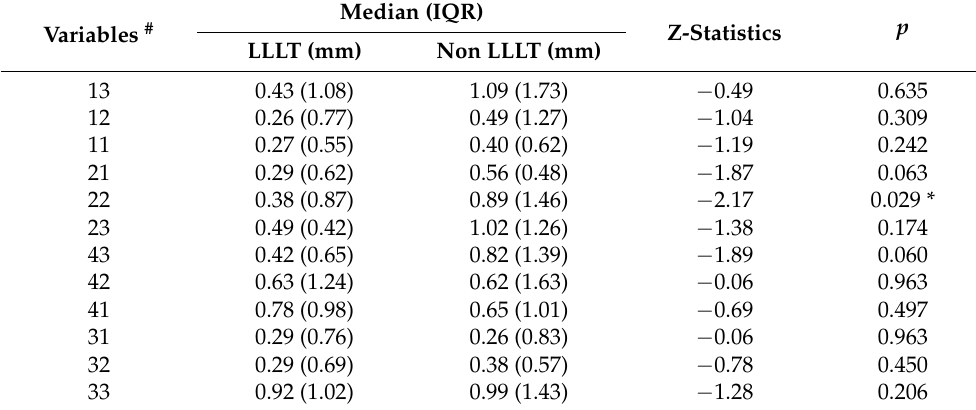
Table 5. Root resorption between LLLT and non LLLT group, regardless of bracket system.